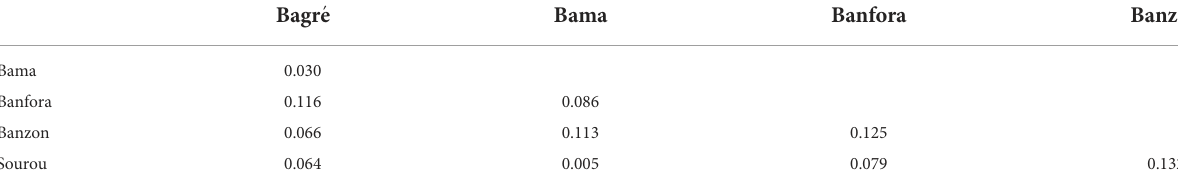
TABLE 3 Analysis of molecular variance (AMOVA) of Bipolaris oryzae among and within fi ve rice-growing zones in Burkina Faso. Localities